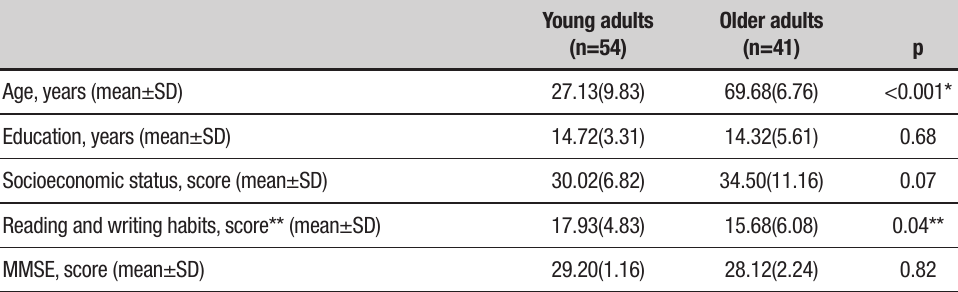
Table 1. Sociodemographic characteristics of the